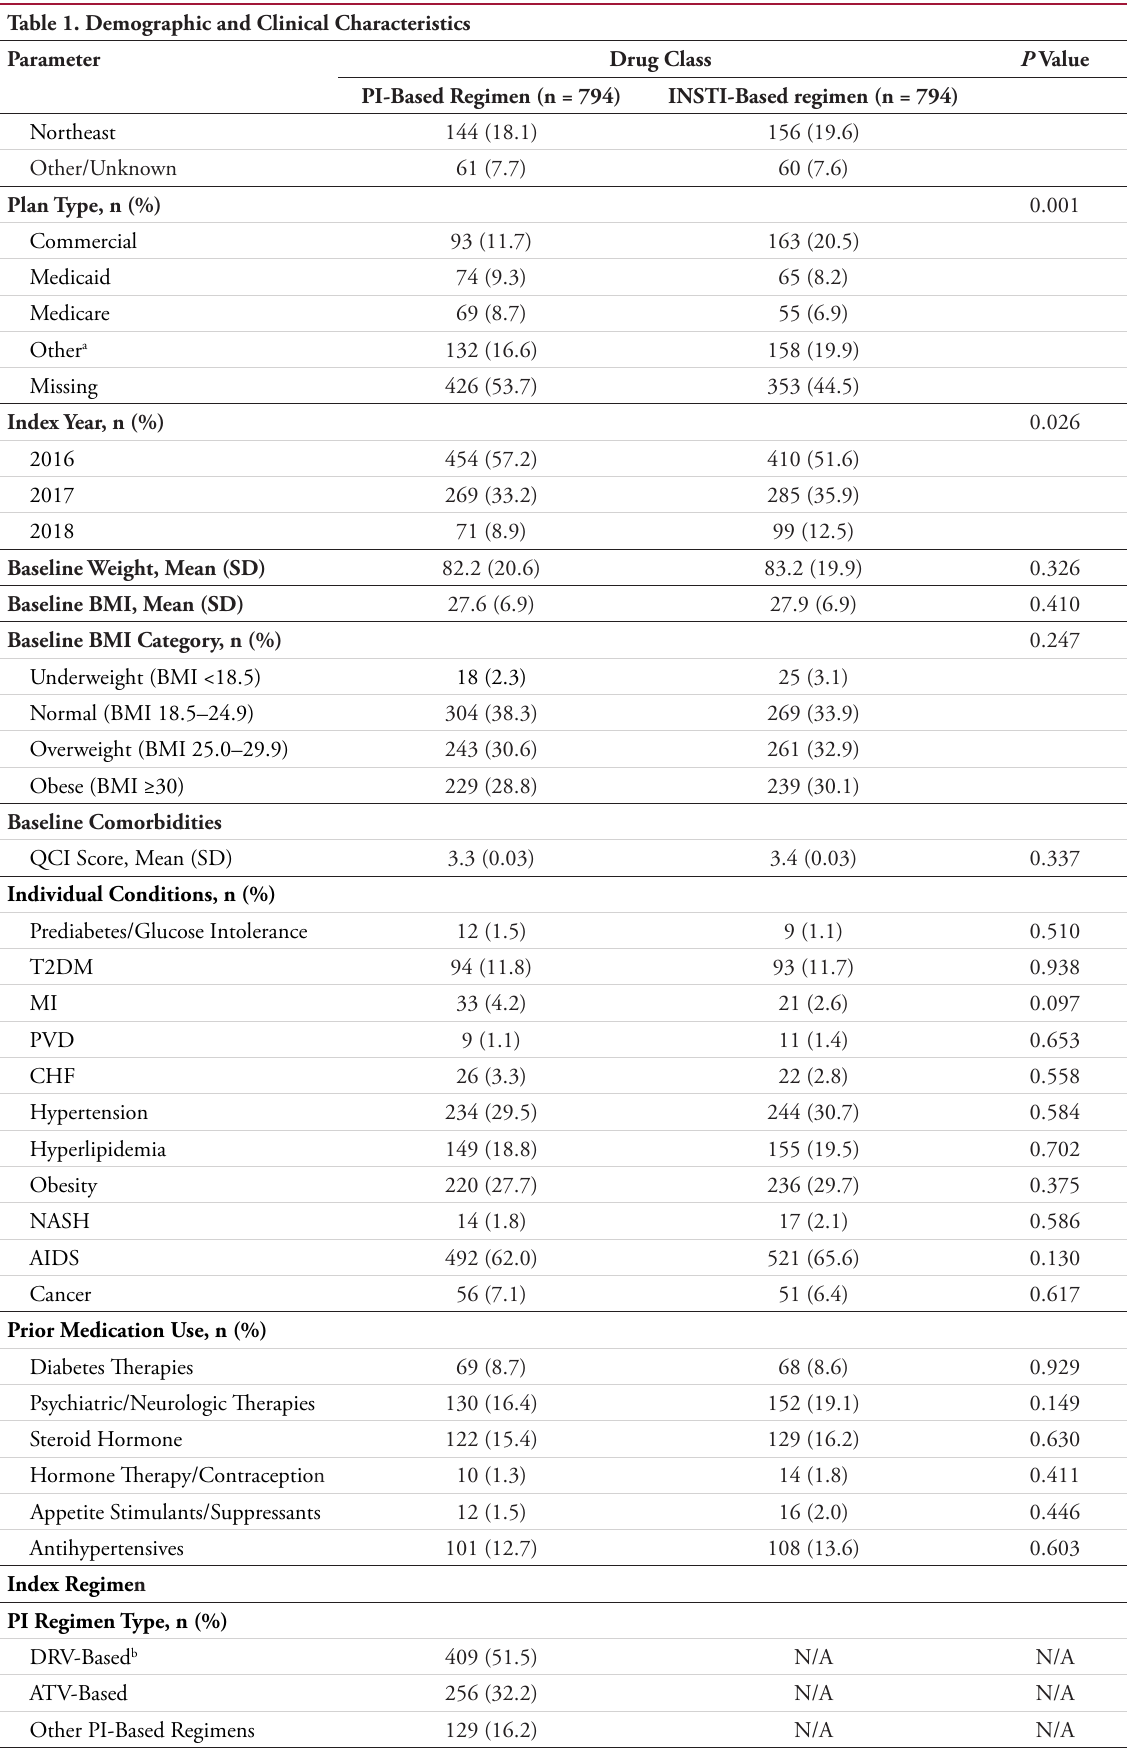
Table 1. Demographic and Clinical